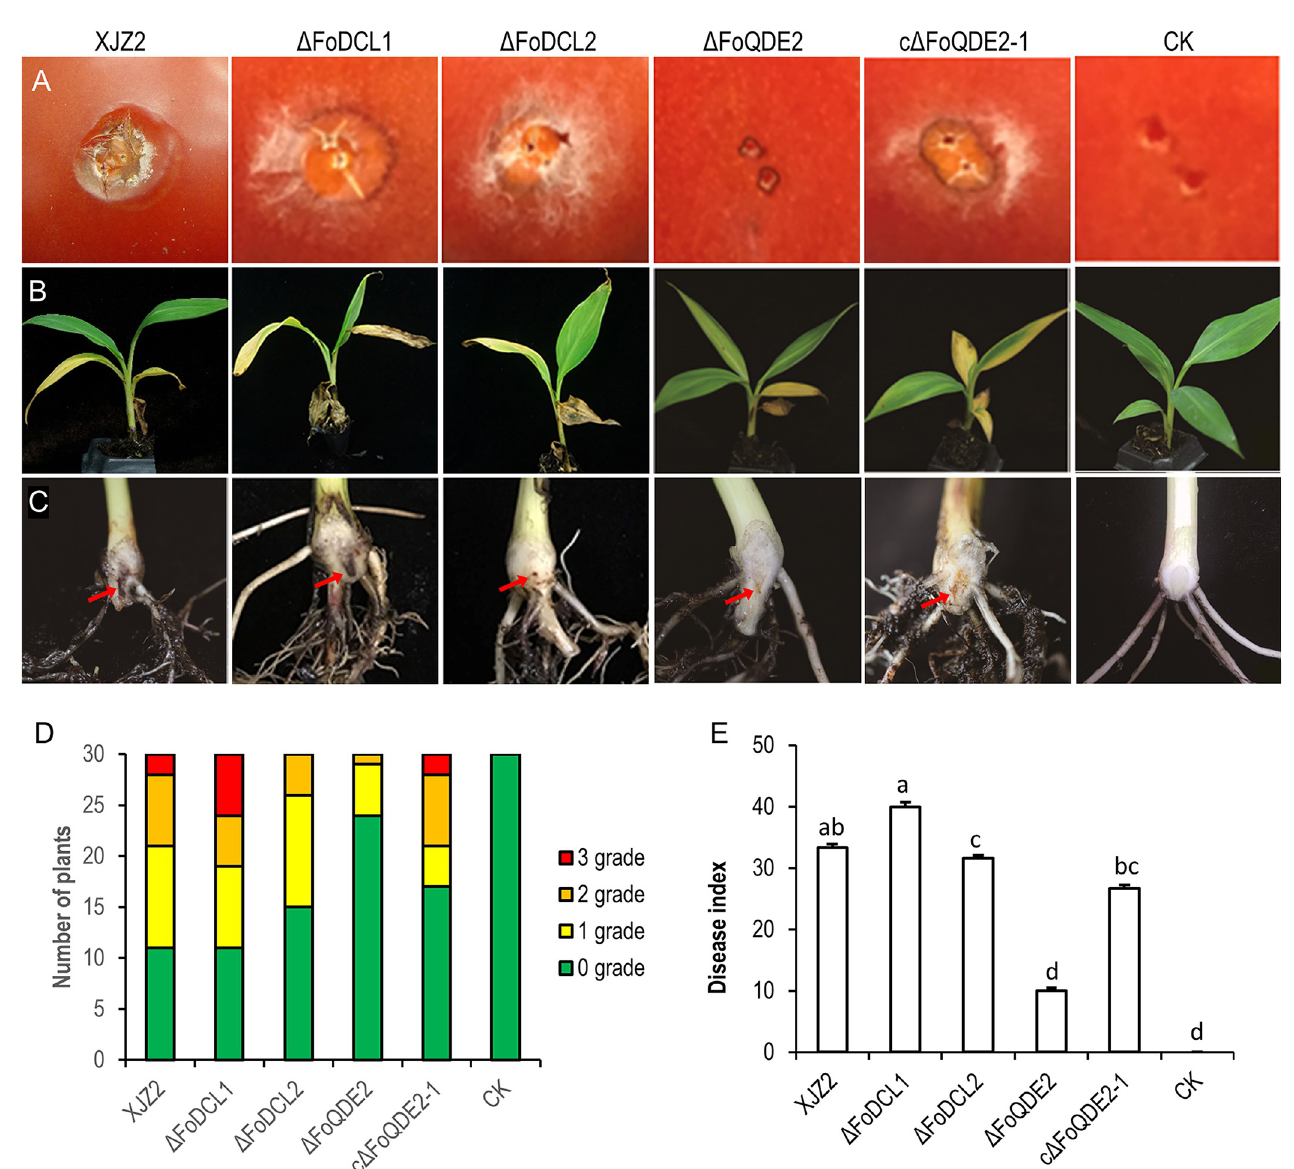
Fig 3. Pathogenicity assay. ( A ) Invasive growth on tomato fruits. The surfaces of tomato fruits were inoculated with the WT strain XJZ2, Δ FoQDE2 mutant, the c Δ FoQDE2 -1 complementation transformant, and water control (CK). The incidence of necrosis on tomato fruits was assessed at 5 days post inoculation. ( B ) and ( C ) Symptoms of pathogenicity on the leaves (B) and corm (C) of the banana plant. ( D ) and ( E ) Disease severity analyzed by diseased plantlet number of different disease grade (D) and disease index (E). The disease grade was classified as 0 (no symptoms in the corm of the banana plantlet), 1 (the presence of small vascular discoloration like brown dots), 2 (up to 50% of vascular discoloration) and 3 (greater than 50% of vascular discoloration). Different letters indicate significant difference at the level of α = 0.01.